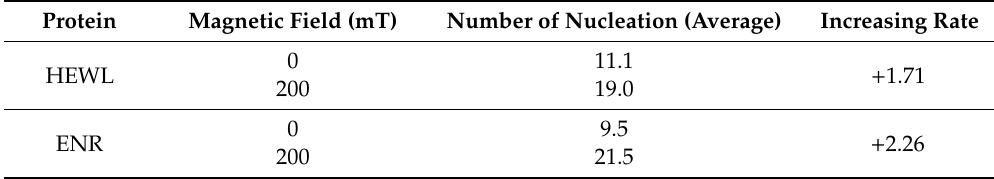
Figure 6. Comparison of HEWL crystal growth under a magnetic field: number of crystallization screening hits under the magnetic field. ( a ) Number of crystals per well. ( b ) Number of crystals based on the ratio of protein solutions per reservoir. ( c ) Volume (a × b × c) of the crystals. Table 2. Nucleation rate per drop with and without a magnetic field.